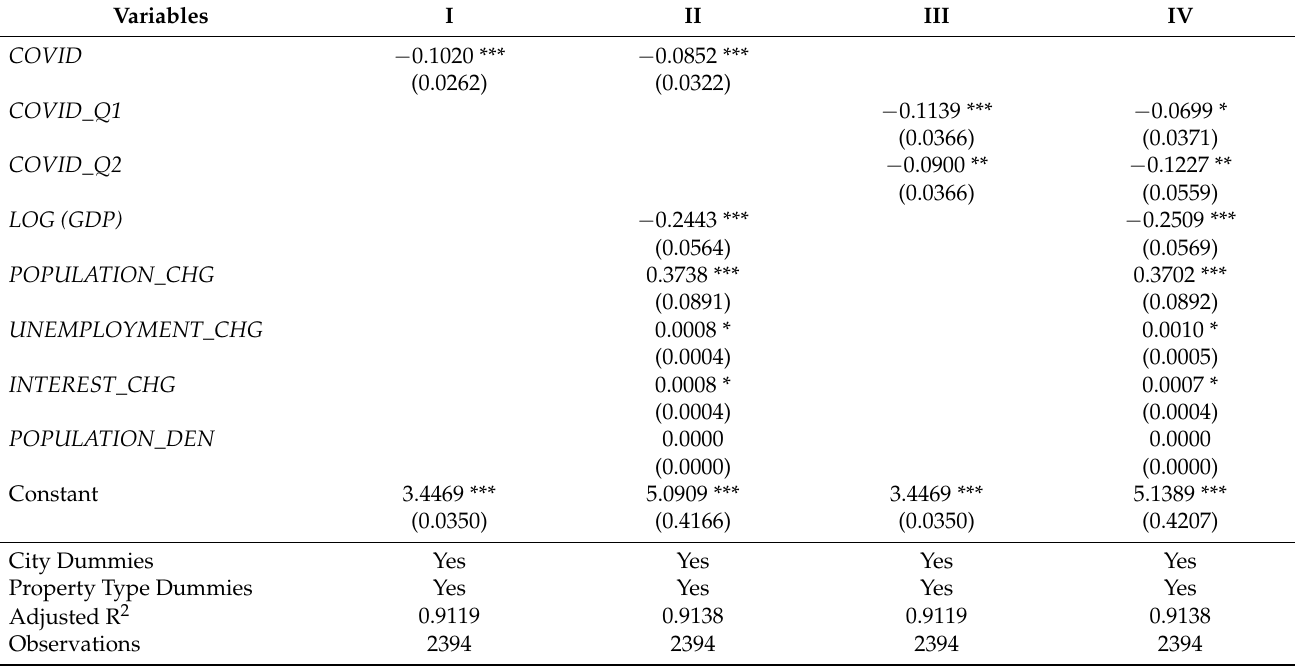
Table 9. Robustness Analysis on Subsample Excluding Mainland China. This table presents the OLS regression estimation results of testing the impact of the COVID-19 pandemic on commercial real estate rent on a subsample excluding Mainland Chinese cities. The dependent variable is LOG (RENT) , the natural logarithm of rent for the specific city and property type. The independent variables of interest are COVID, COVID_Q1 and COVID_Q2 . All variables are described in Appendix A. The standard errors are reported in parentheses. ***, **, and * denote significance of the t-statistics at the <1%, 5% and 10% levels,